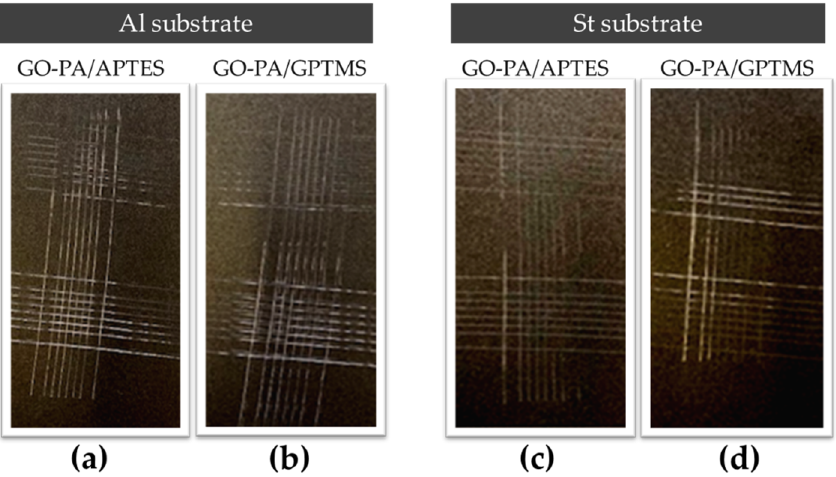
Figure 13. Pull-off adhesion test of paint on aluminum ( a – c ) and steel ( d – f ) substrates treated with GO-PA/GPTMS ( c , f ) and GO-PA/APTES ( b , e ) coatings.